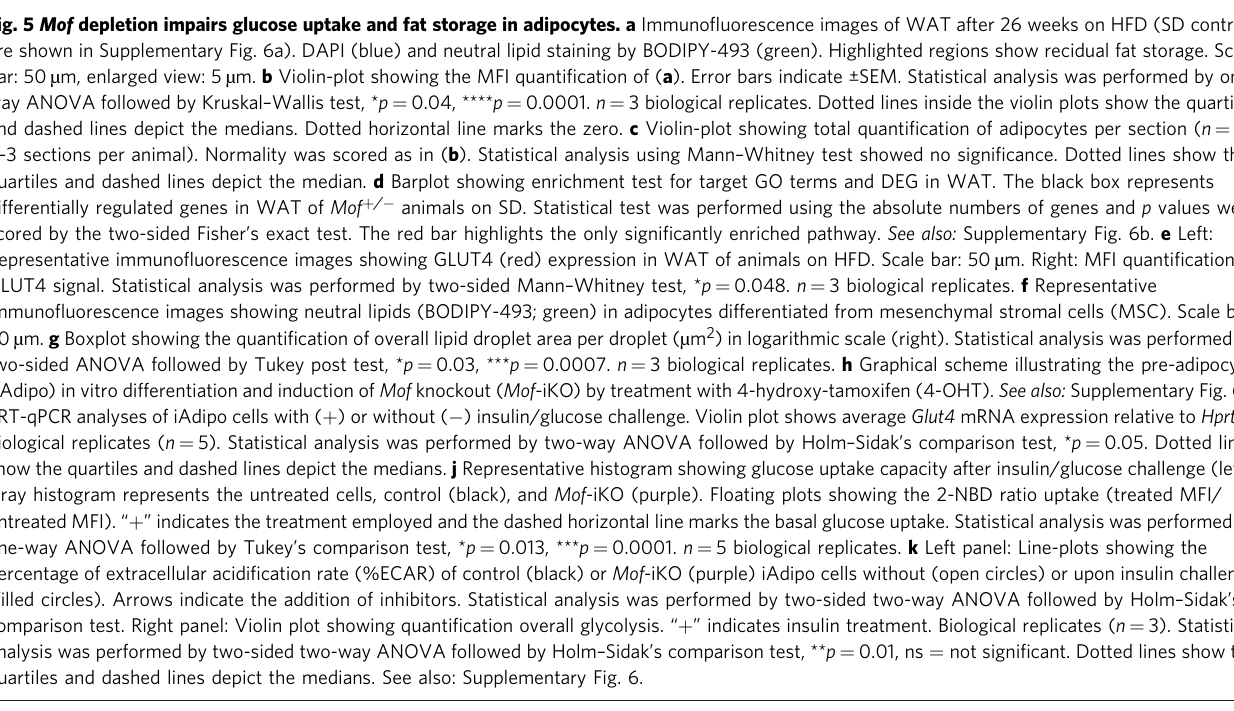
Fig. 5 Mof depletion impairs glucose uptake and fat storage in adipocytes. a Immuno fl uorescence images of WAT after 26 weeks on HFD (SD controls are shown in Supplementary Fig. 6a). DAPI (blue) and neutral lipid staining by BODIPY-493 (green). Highlighted regions show recidual fat storage. Scale bar: 50 µ m, enlarged view: 5 µ m. b Violin-plot showing the MFI quanti fi cation of ( a ). Error bars indicate ±SEM. Statistical analysis was performed by one- way ANOVA followed by Kruskal – Wallis test, * p = 0.04, **** p = 0.0001. n = 3 biological replicates. Dotted lines inside the violin plots show the quartiles and dashed lines depict the medians. Dotted horizontal line marks the zero. c Violin-plot showing total quanti fi cation of adipocytes per section ( n = 3, 2 – 3 sections per animal). Normality was scored as in ( b ). Statistical analysis using Mann – Whitney test showed no signi fi cance. Dotted lines show the quartiles and dashed lines depict the median. d Barplot showing enrichment test for target GO terms and DEG in WAT. The black box represents differentially regulated genes in WAT of Mof + / − animals on SD. Statistical test was performed using the absolute numbers of genes and p values were scored by the two-sided Fisher ’ s exact test. The red bar highlights the only signi fi cantly enriched pathway. See also: Supplementary Fig. 6b. e Left: Representative immuno fl uorescence images showing GLUT4 (red) expression in WAT of animals on HFD. Scale bar: 50 µ m. Right: MFI quanti fi cation of GLUT4 signal. Statistical analysis was performed by two-sided Mann – Whitney test, * p = 0.048. n = 3 biological replicates. f Representative immuno fl uorescence images showing neutral lipids (BODIPY-493; green) in adipocytes differentiated from mesenchymal stromal cells (MSC). Scale bar: 20 µ m. g Boxplot showing the quanti fi cation of overall lipid droplet area per droplet ( µ m 2 ) in logarithmic scale (right). Statistical analysis was performed by two-sided ANOVA followed by Tukey post test, * p = 0.03, *** p = 0.0007. n = 3 biological replicates. h Graphical scheme illustrating the pre-adipocyte (iAdipo) in vitro differentiation and induction of Mof knockout ( Mof -iKO) by treatment with 4-hydroxy-tamoxifen (4-OHT). See also: Supplementary Fig. 6e. i RT-qPCR analyses of iAdipo cells with ( + ) or without ( − ) insulin/glucose challenge. Violin plot shows average Glut4 mRNA expression relative to Hprt of biological replicates ( n = 5). Statistical analysis was performed by two-way ANOVA followed by Holm – Sidak ’ s comparison test, * p = 0.05. Dotted lines show the quartiles and dashed lines depict the medians. j Representative histogram showing glucose uptake capacity after insulin/glucose challenge (left). Gray histogram represents the untreated cells, control (black), and Mof -iKO (purple). Floating plots showing the 2-NBD ratio uptake (treated MFI/ untreated MFI). “ + ” indicates the treatment employed and the dashed horizontal line marks the basal glucose uptake. Statistical analysis was performed by one-way ANOVA followed by Tukey ’ s comparison test, * p = 0.013, *** p = 0.0001. n = 5 biological replicates. k Left panel: Line-plots showing the percentage of extracellular acidi fi cation rate (%ECAR) of control (black) or Mof -iKO (purple) iAdipo cells without (open circles) or upon insulin challenge ( fi lled circles). Arrows indicate the addition of inhibitors. Statistical analysis was performed by two-sided two-way ANOVA followed by Holm – Sidak ’ s comparison test. Right panel: Violin plot showing quanti fi cation overall glycolysis. “ + ” indicates insulin treatment. Biological replicates ( n = 3). Statistical analysis was performed by two-sided two-way ANOVA followed by Holm – Sidak ’ s comparison test, ** p = 0.01, ns = not signi fi cant. Dotted lines show the quartiles and dashed lines depict the medians. See also: Supplementary Fig.